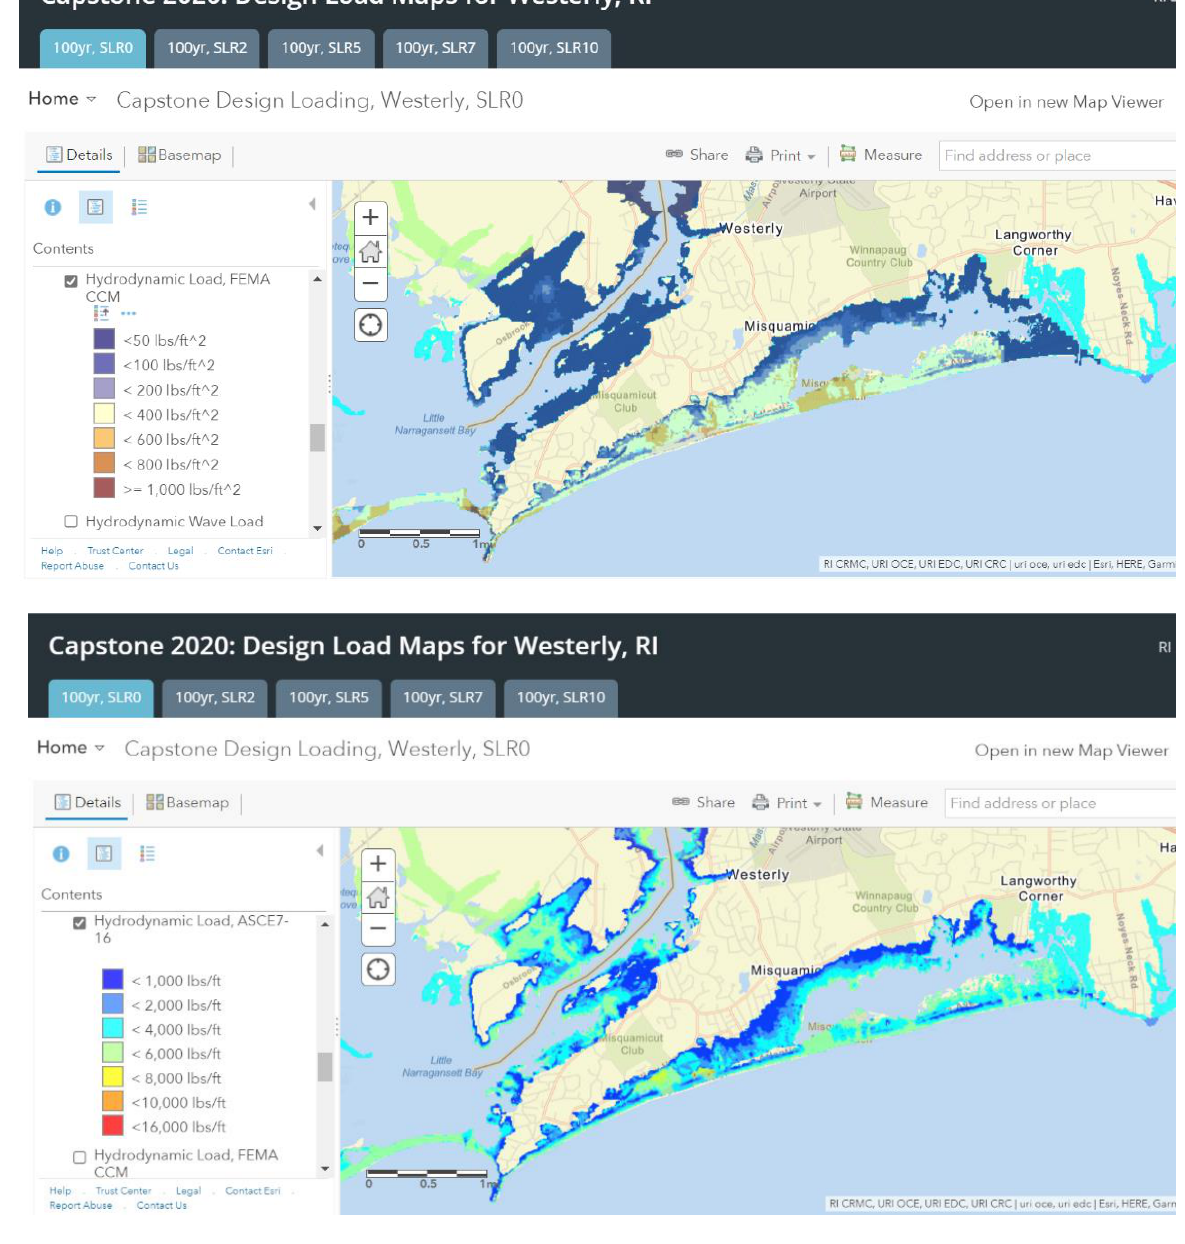
Figure 10. Hydrodynamic load (lbs/ft 2 ) for FEMA CCM [10] method ( upper panel), ASCE/SEI 7–16 [9] method ( lower panel) (lbs/ft), 100 yr storm, no sea level rise (SLR). It is noted the loads for the FEMA CCM method are based on the cross-sectional area (A= h s ∗ w) (lbs/ft 2 ) while those from ASCE/SEI 7–16 are based on structure width (lbs/ft).